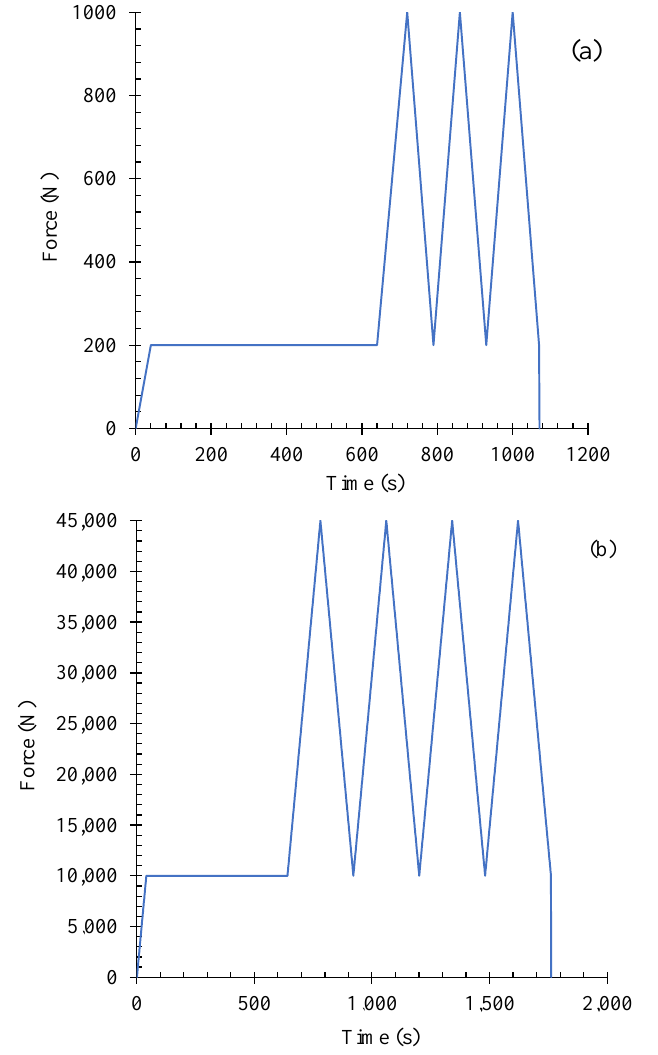
Figure 6. Cyclic loading patterns used for piezoresistivity behaviour investigations: ( a ) flexural mode, ( b ) compression mode.